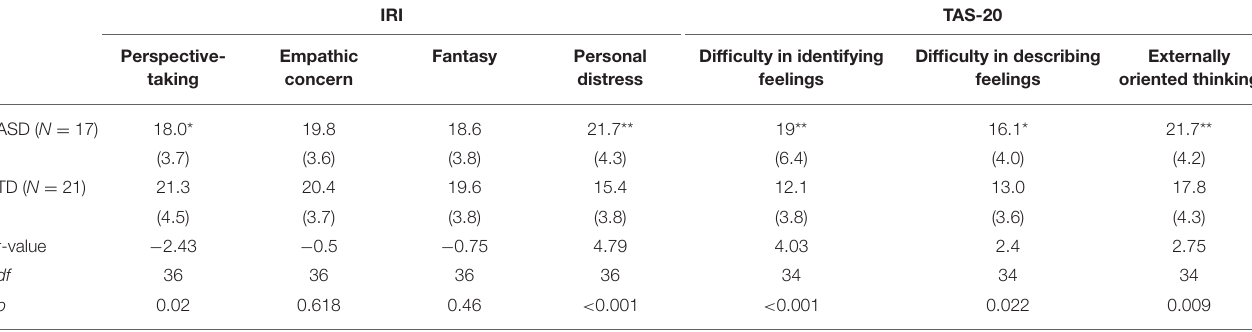
TABLE 4 | Spearman’s rank-order correlation coefficients between averaged probability and scores of IRI and TAS-20. IRI Perspective- Fantasy Difficulty in identifying taking